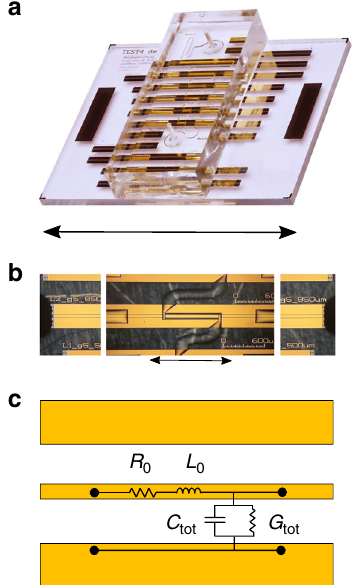
Fig. 2 Microwave micro fl uidics devices and circuit schematic. a Image of the microwave micro fl uidics device (scale bar is 12 mm). b Composite microscope image of micro fl uidic channels with microwave probes landed (scale bar is 1 mm). c Circuit model that describes the electrical behavior of the CPW. The distributed circuit parameters R 0 , L 0 , C tot , and G tot are frequency-dependent per unit length quantities, and C tot and G tot depend on the fl uid